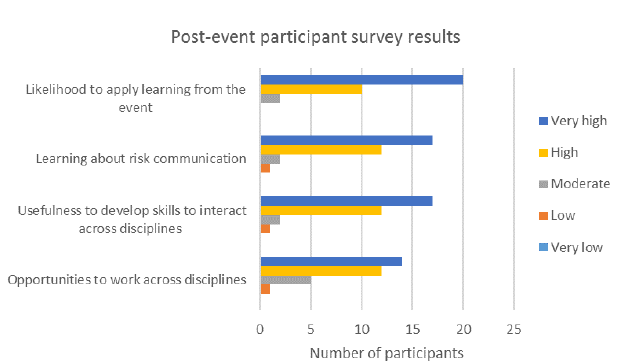
Figure 5. Post-event survey results asking participants to self-rank on working across disciplines and risk communication learning (data based on graphs presented in Water Youth Network,